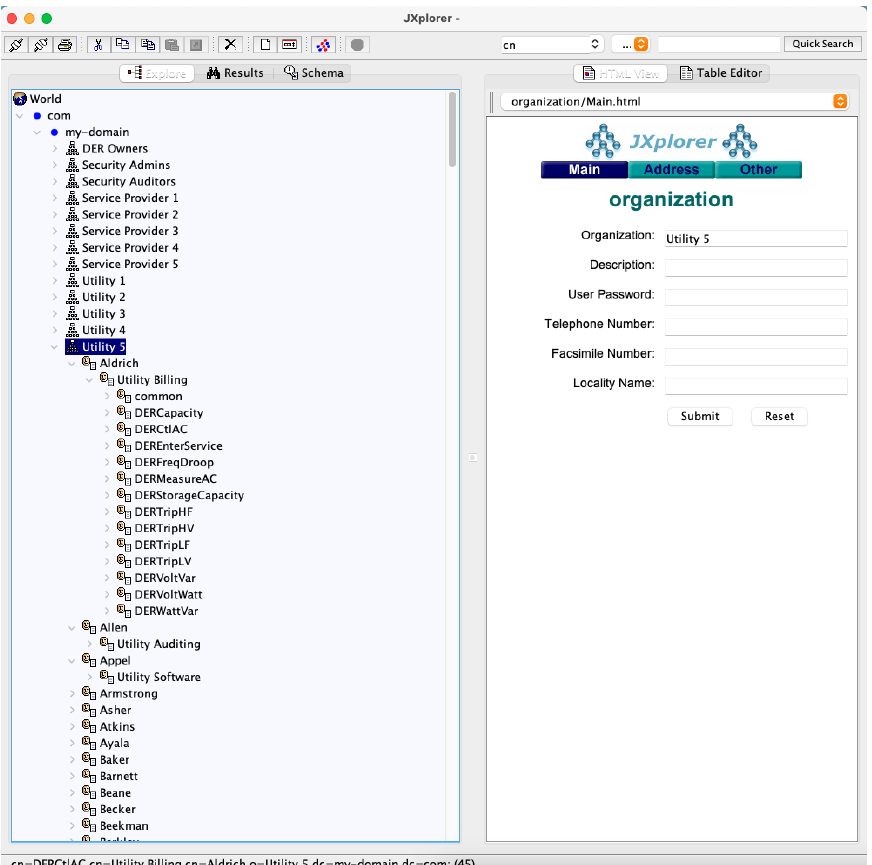
Figure 8. JXplorer & the DIT